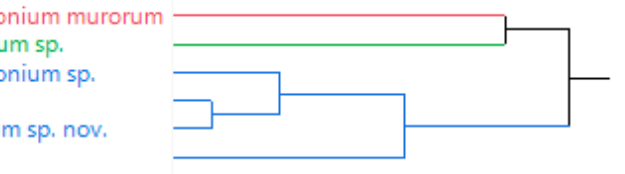
Figure 4. Hierarchical clustering (HCA) was applied using the Ward’s method. Clustering between symbionts and volatile emissions was selected.